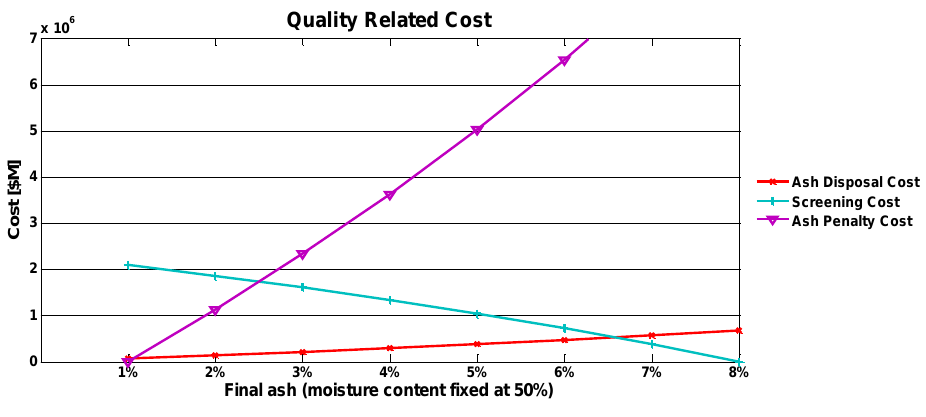
Figure 5. Ash quality-related costs.